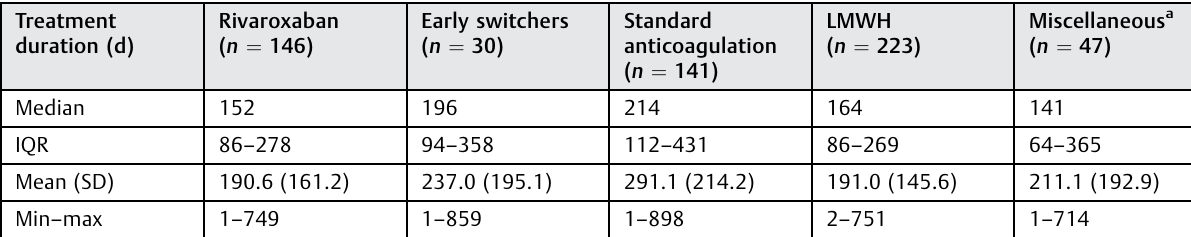
Table 2 Treatment duration in patients with cancer